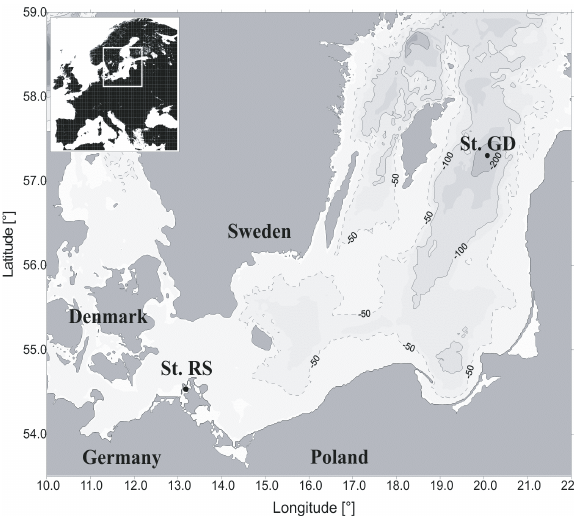
Fig. 1. Sampling stations in the Baltic Sea. Station Rassower Strom (RS) in the Bodden next to the island R¨ugen (Germany) and Gotland Deep (GD) in the central Baltic Sea (Map courtesy of Jan Donath, Baltic Sea Research Institute